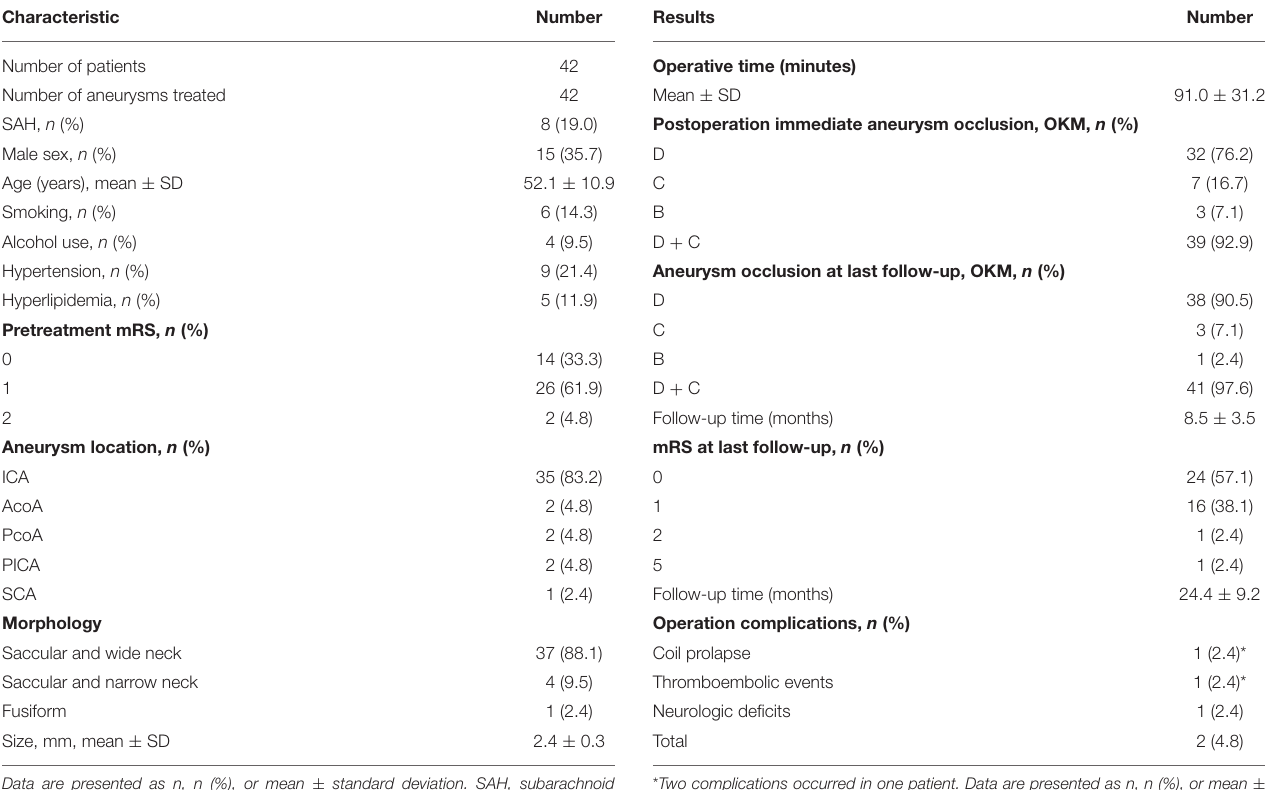
TABLE 1 | Patients’ baseline characteristics. TABLE 2 | Treatment outcomes and